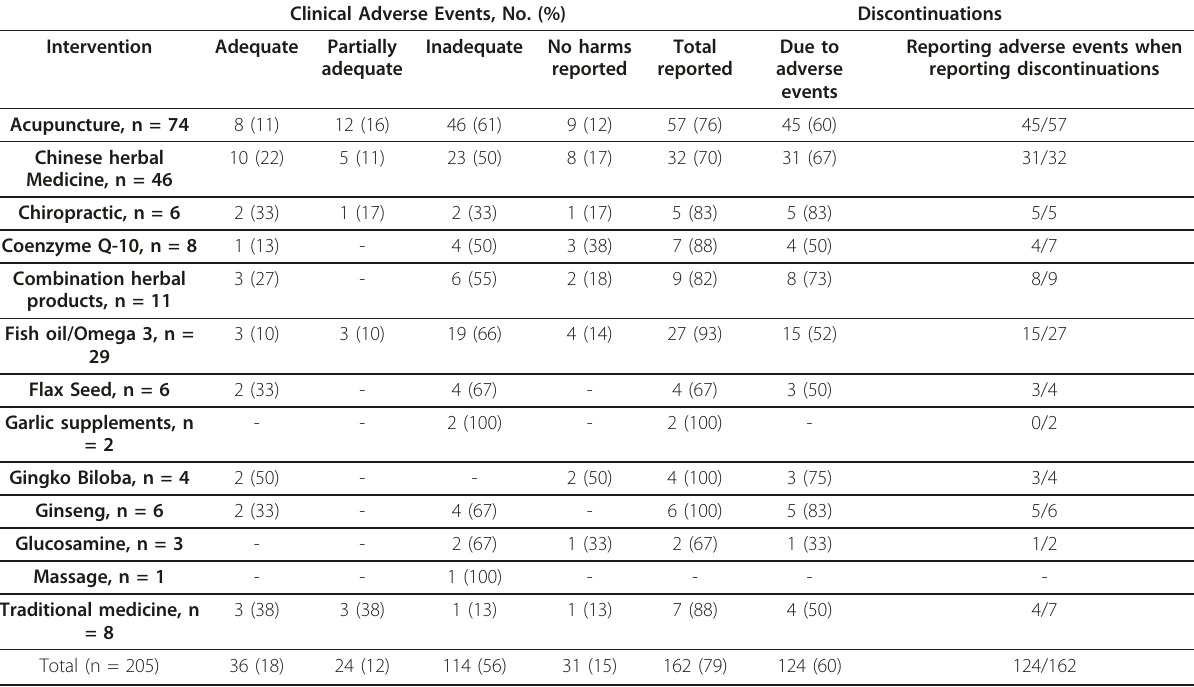
Table 2 Safety Reporting: Qualitative measures